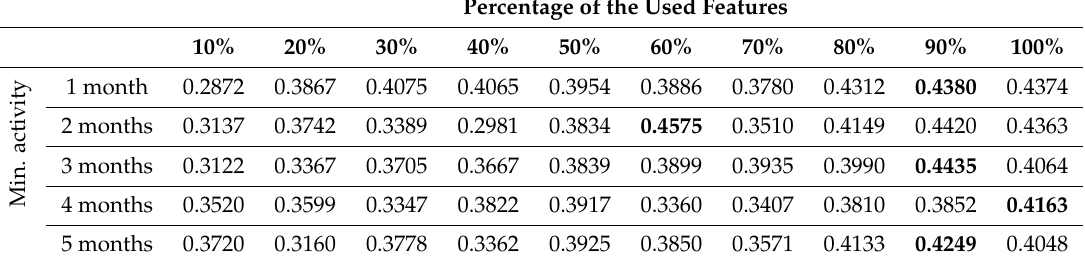
Table A7. F-score macro average for the Random Forest classification of three levels of the hierarchy in the manufacturing company dataset. The values which are bolded are the best results for a given minimum communication